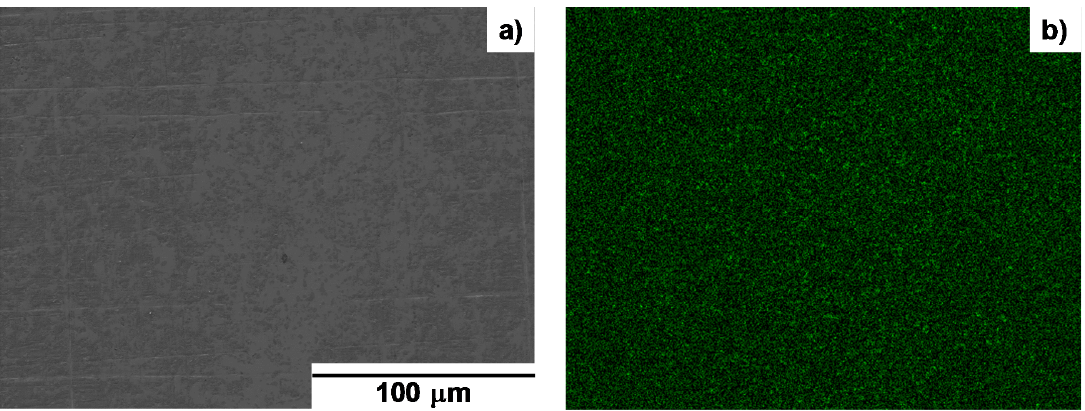
Figure 3. SEM image and nitrogen mapping on the ground and polished surface of nitrided AISI420 at 673 K for 3.6 ks; ( a ) SEM image; ( b ) nitrogen mapping by EDX.